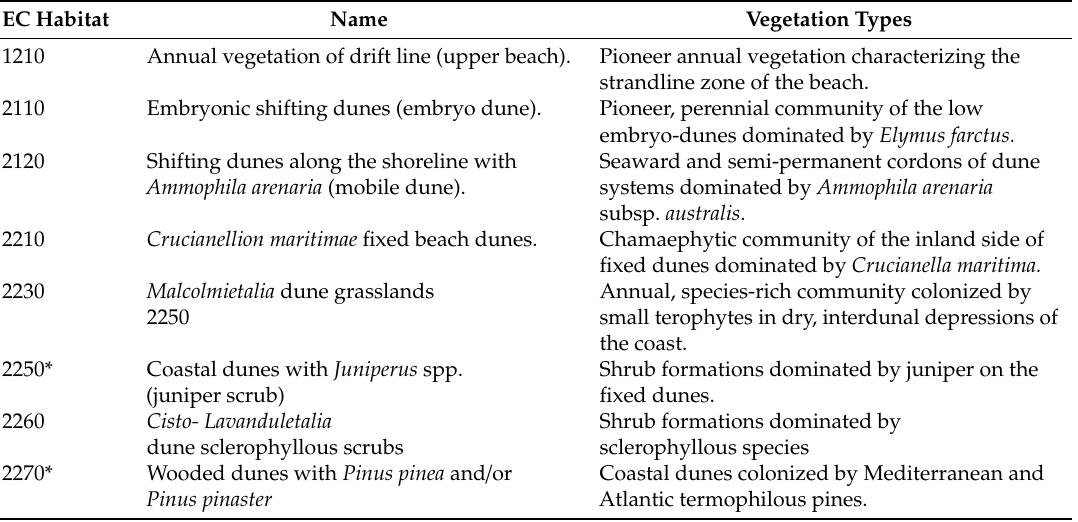
Table 1. EC Habitat types (Habitat Directive 92 / 43 / EEC) along with a brief description in terms of vegetation types [53]. Asterisk (*) indicates habitats with high priority for conservation.